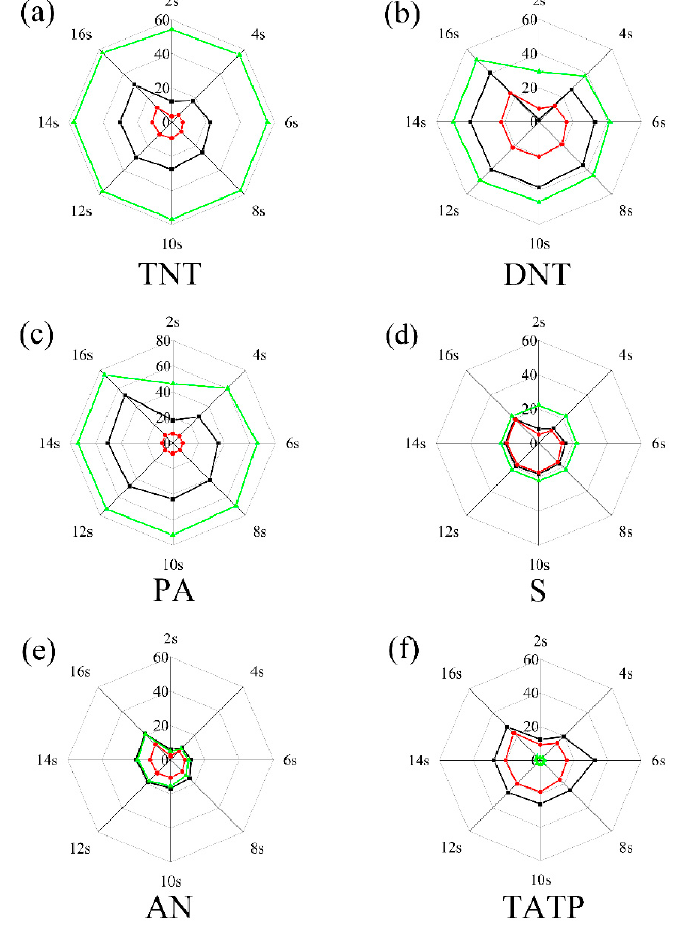
Figure 9. Fingerprint patterns collection of ( a ) TNT; ( b ) DNT; ( c ) PA; ( d ) S; ( e ) AN and ( f ) TATP by the response value at corresponding response time under 365 nm (black line), 450 nm (red line) and 550 nm (green line).